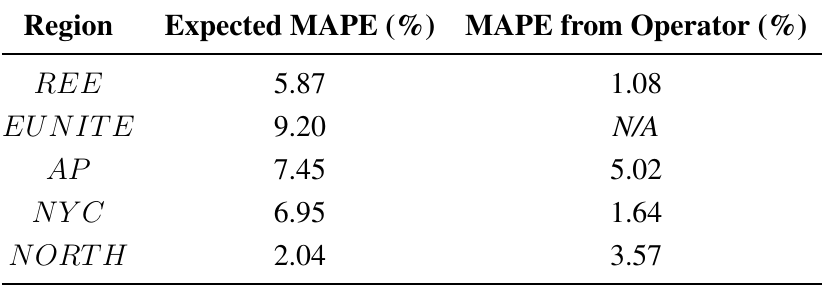
Table 2. Summary of the region’s features. N/A denotes no available values. Note that TSOs use forecasting models especially tailored to their respective consumption